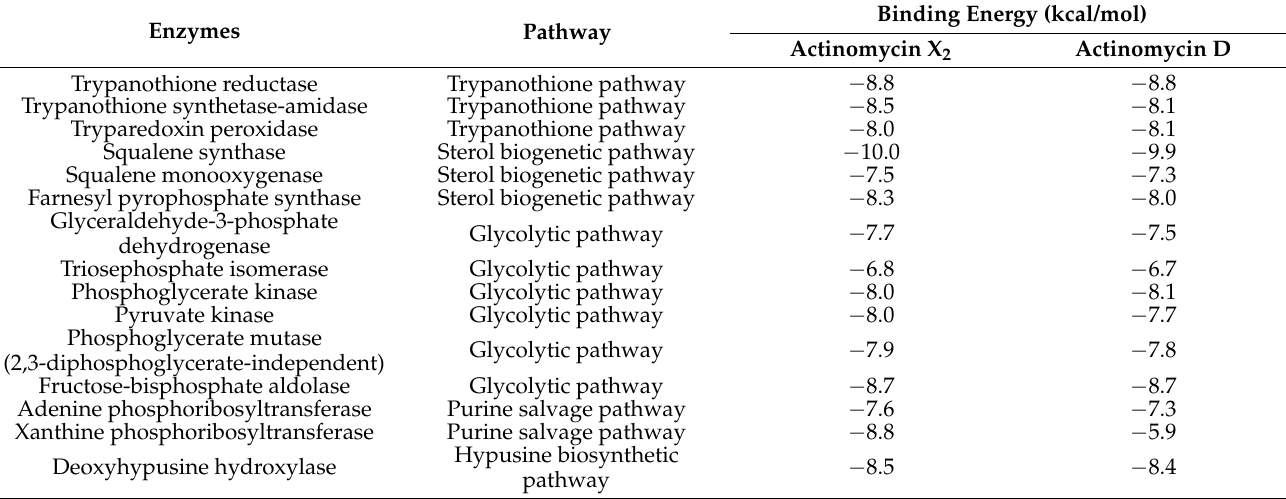
Table 3. Protein-ligand predicted binding energy obtained from molecular